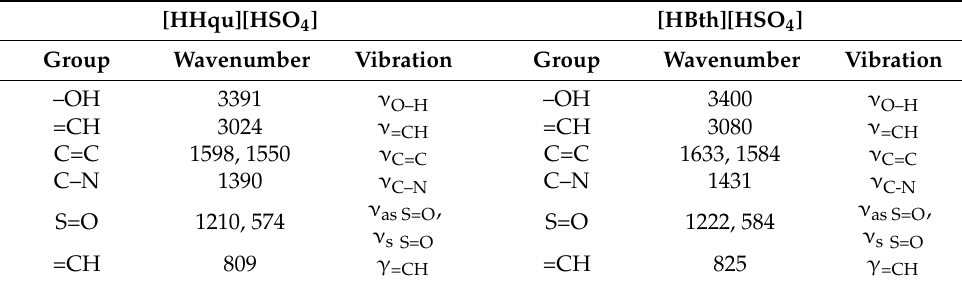
Table 2. FI-IR spectra analysis of [HHqu][HSO 4 ] and [HBth][HSO 4 ].